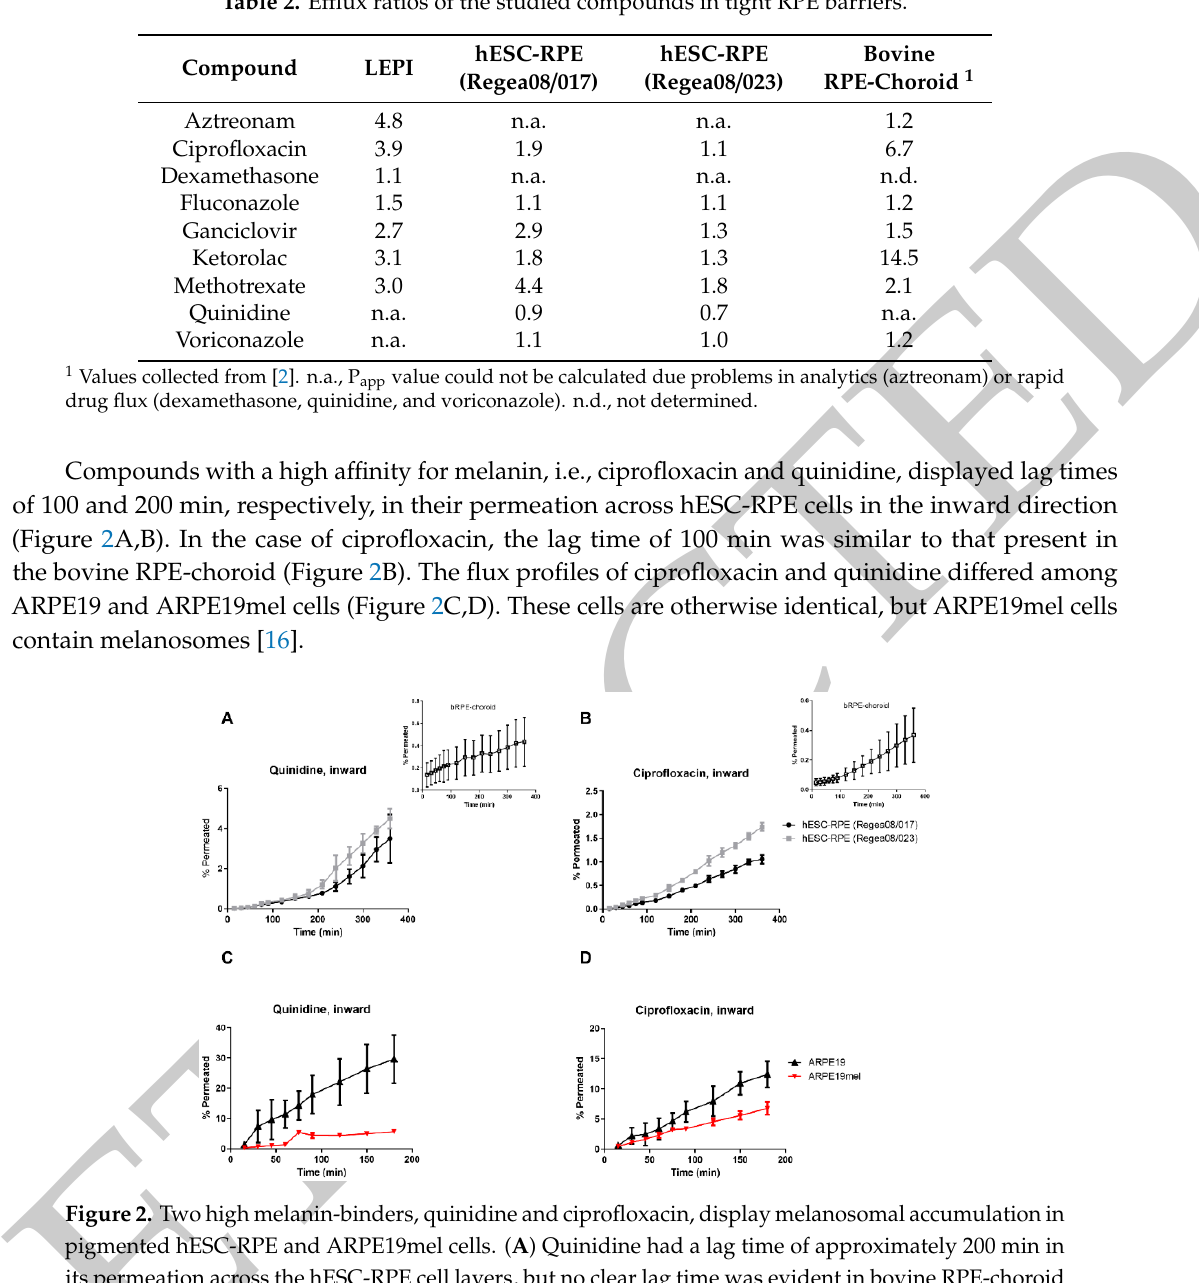
Table 2. Efflux ratios of the studied compounds in tight RPE barriers. Table 2. E ffl ux ratios of the studied compounds in tight RPE barriers.